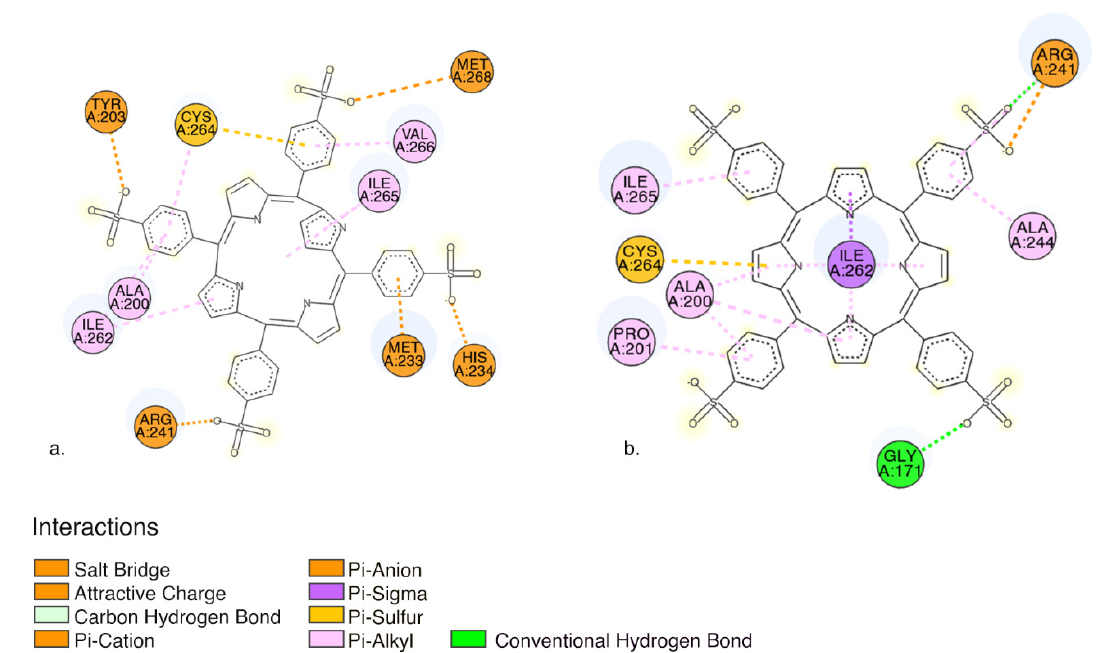
Figure 10. 2D visualization of ( a ) interactions between TPPS and pro-caspase3 amino acid residues ( b ) interactions between TPPS and caspase3 amino acid residues. The image was obtained using Discovery studio visualizer. (Dassault Systèmes (V20.1.0.19295), San Diego, CA, USA).